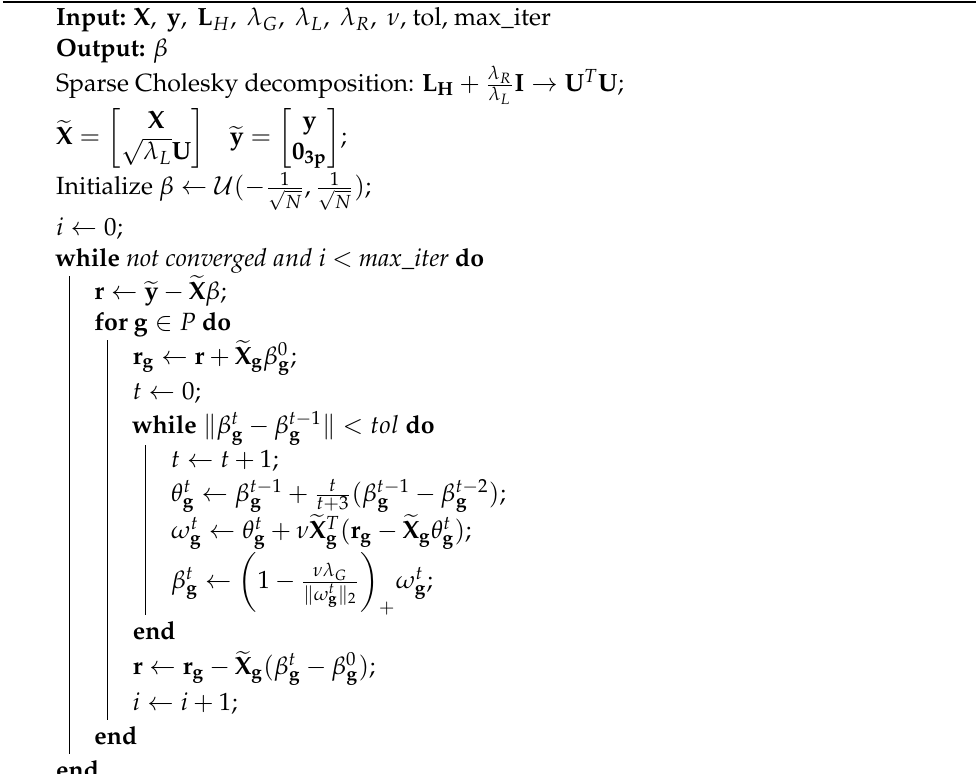
Algorithm 1: Hypergraph regularized group